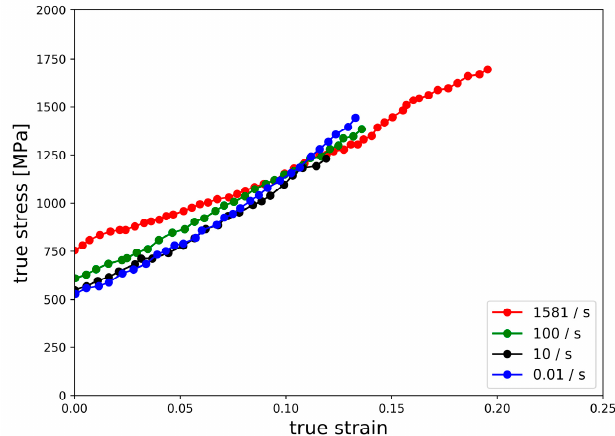
Figure 2. Compressive true stress–strain responses of Fe-18Mn-0.6C-1.5Al TWIP steel from yield onward as a function of different strain rates.